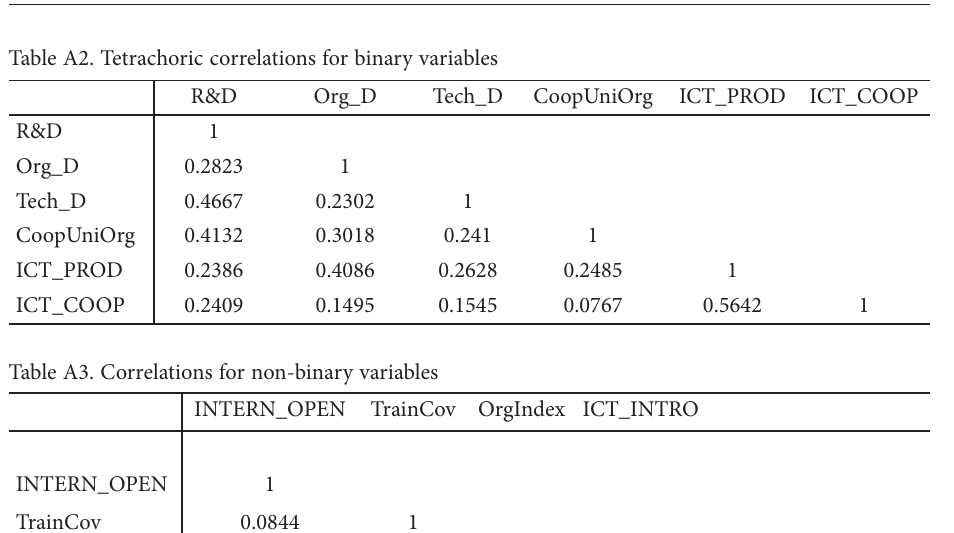
States of the world (555 obs.) States of the world (183 obs.) whole sample % polluting sectors %